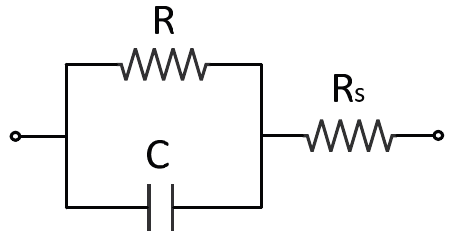
Figure 3. Equivalent electric circuit of a LC cell for a frequency range of 100 to 10 5